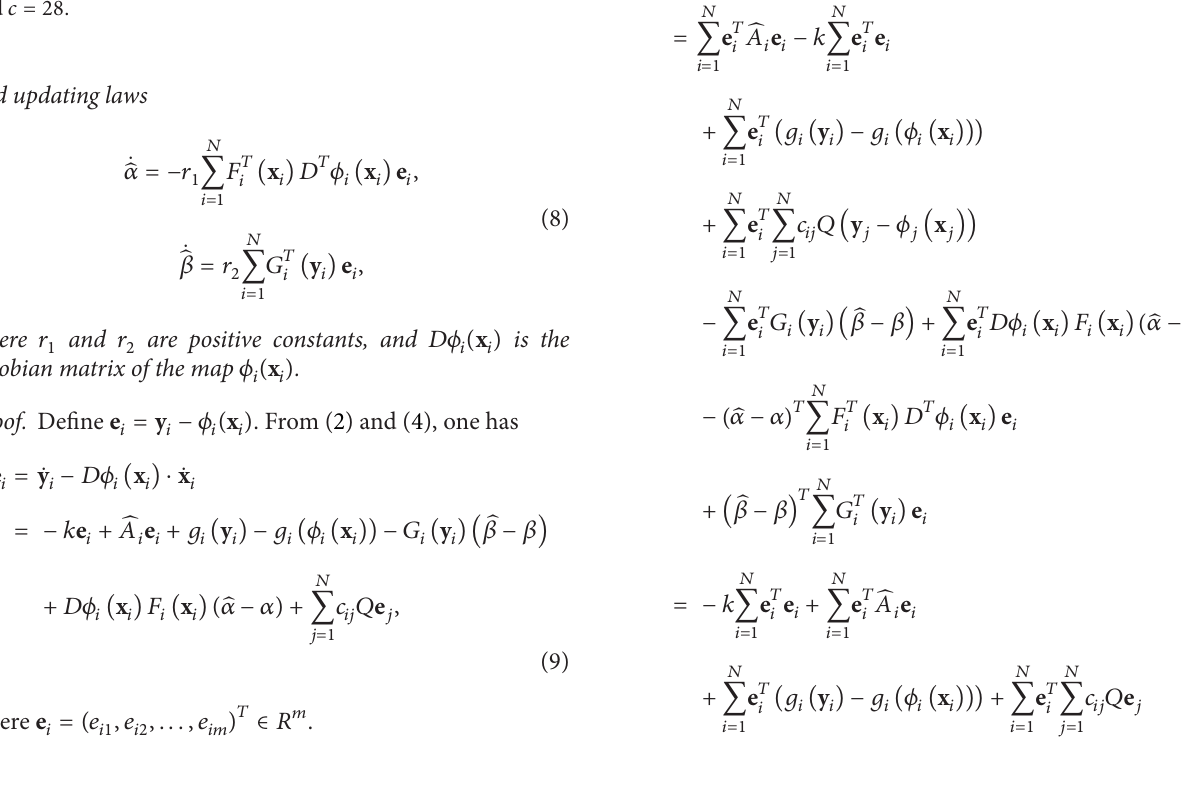
Figure 2: Phase diagram of the Lorenz attractor for 𝑎 = 10 , 𝑏 = 8/3 , and 𝑐 = 28